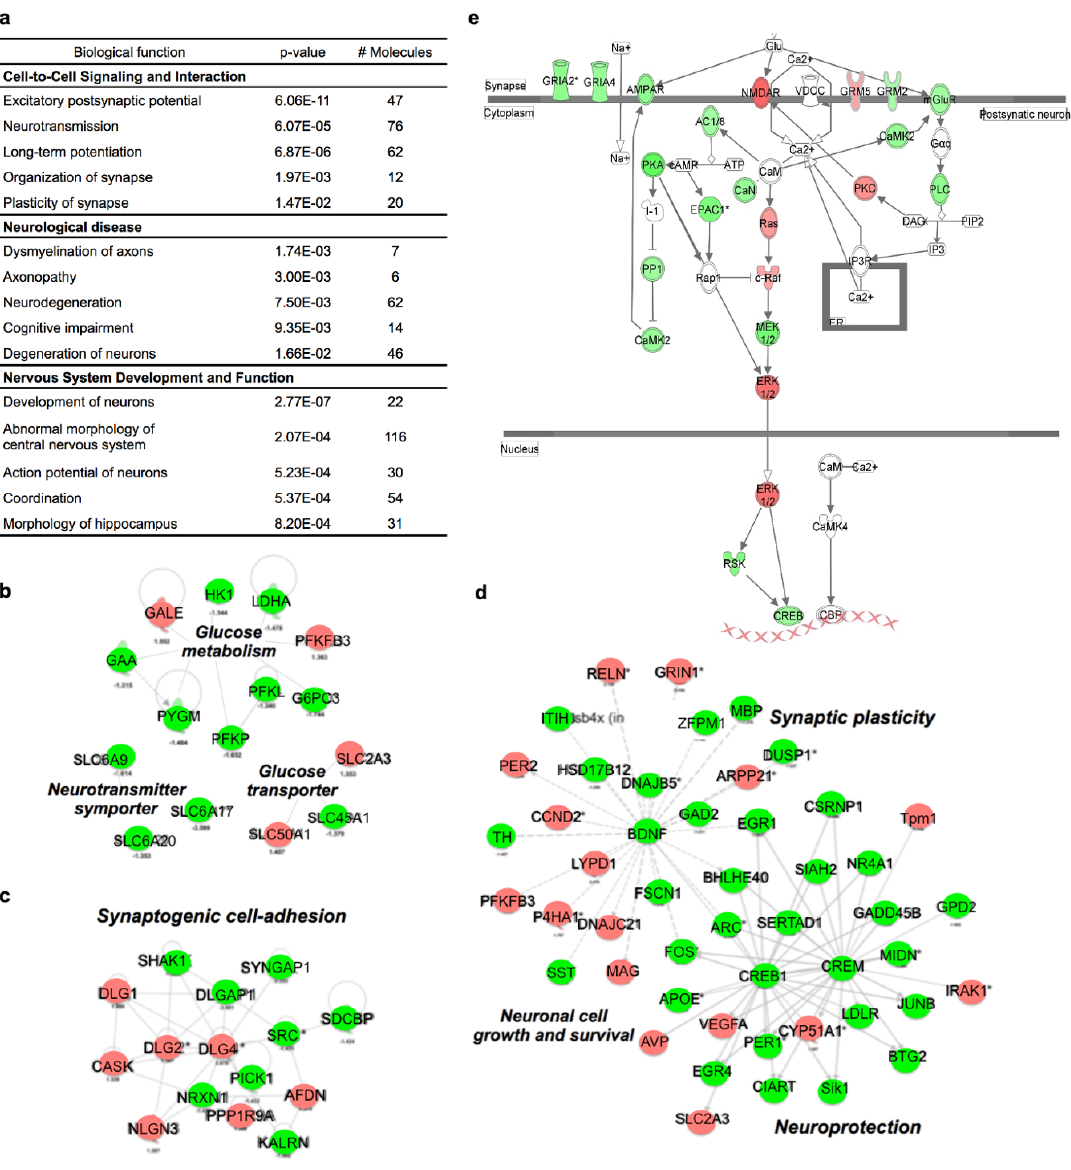
Figure 2. Dehydration alters hippocampal transcriptional networks. A hippocampal transcriptional networkanalysiswasperformed,comprisingnext-generationRNAsequencingandbioinformaticanalyses. ( a ) Genes that were differentially regulated between the control (CON) and dehydrated (DEH) mice were classified into functional categories via an Ingenuity Pathway Analysis (IPA). Significantly changed biological functions are indicated by p -values calculated using a Fisher’s exact test, and the number of distinctively modulated molecules in each functional category is indicated. ( b – d ) Transcriptional networks related to altered glucose metabolism, synaptogenic cell-adhesion, and synaptic plasticity were differentially regulated in response to long-term dehydration. ( e ) Genes associated with long-term potentiation (LTP) signaling transduction were differentially up- (red) or downregulated (green) in the DEH compared to the CON